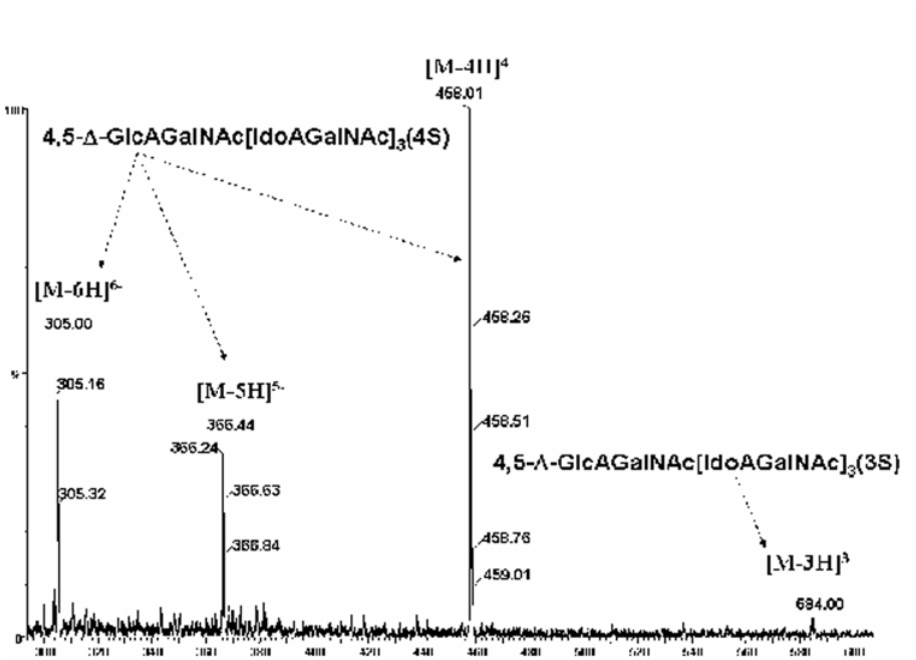
FIGURE 2. Negative ion mode chip nanoESI QTOF mass spectrum of the DS octasaccharide fraction released from human skin fibroblasts decorin by β -elimination and deploymerization with chondroitin AC lyase. The octasaccharide fraction was separated by SEC and purified using Sephadex G25 prior to chip MS